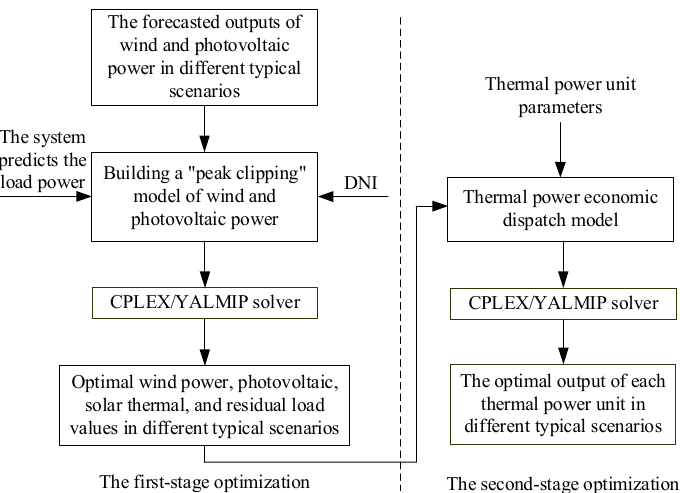
Figure 2. Two‑stage optimal scheduling model of wind‑photovoltaic‑thermal‑thermal power com‑ Figure 2. Two-stage optimal scheduling model of wind-photovoltaic-thermal-thermal power com- bined power generation system . bined power generation